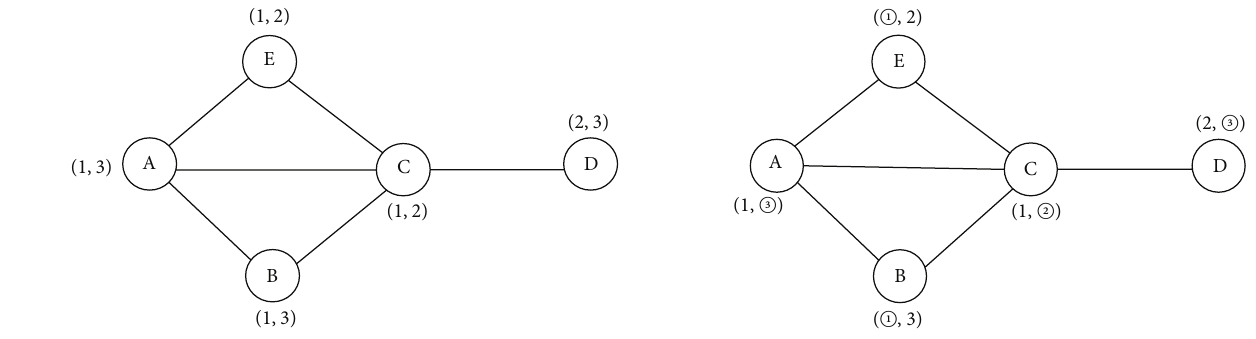
Figure 1: The list of graph. Figure 2: The list coloring of